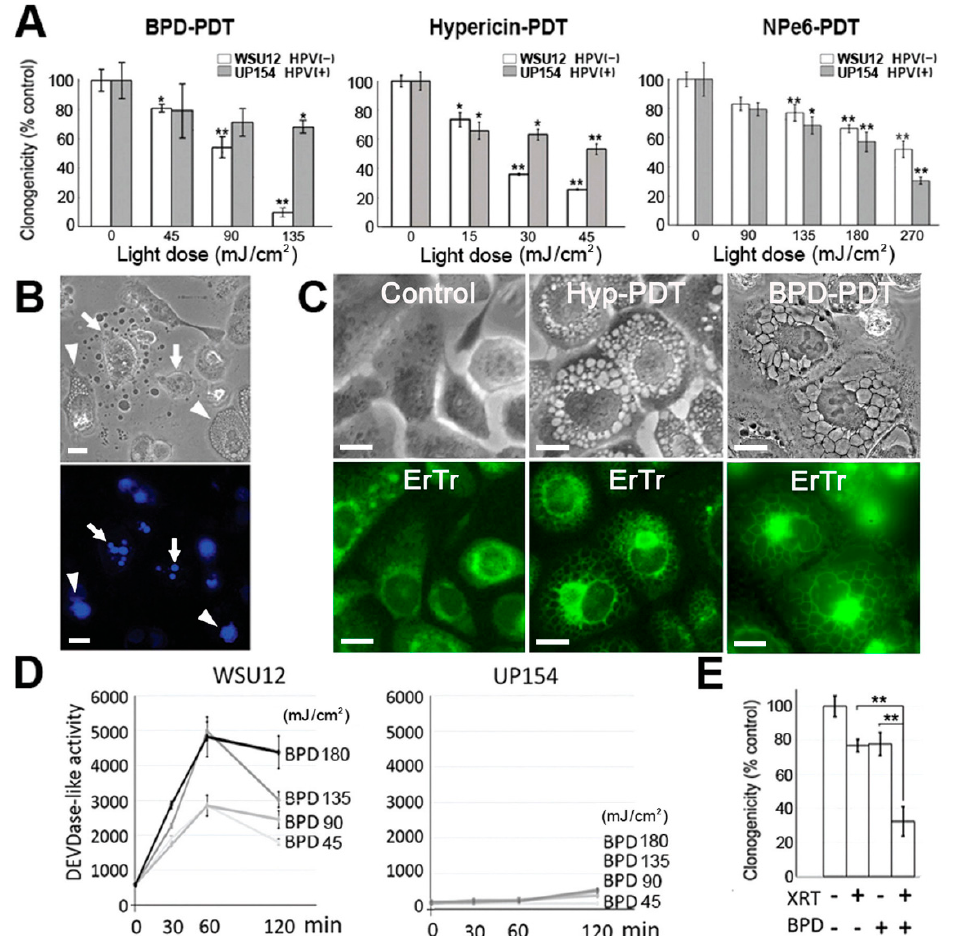
Figure 2. Endoplasmic reticulum (ER)/mitochondria-targeted PDT enhanced ionizing radiation therapy (XRT)-mediated cytotoxicity in HPV-negative WSU12 cells, but not in HPV-positive UP154 cells, via paraptosis and apoptosis. ( A ) Clonogenic cell survival assay. (* p < 0.05, ** p < 0.01). ( B ) Typical morphologies of apoptosis (arrow) and paraptosis (arrowhead) in WSU12 cells are shown one day after PDT. Top, phase-contrast; bottom, Hö33342 staining. Scale bar, 20 µ m. ( C ) Formation of ER-derived paraptotic vacuoles in WSU12 cells after LD 90 levels of photodamage with hypericin or BPD. Top panels, phase-contrast; bottom panels, ER Tracker. Scale bar, 20 µ m. ( D ) DEVDase activity assay post BPD-PDT. ( E ) Clonogenic cell survival assay of WSU12 cells post BPD-PDT at 22.5 mJ/cm 2 , then immediately exposed to XRT at 2 Gy. (** p < 0.01).